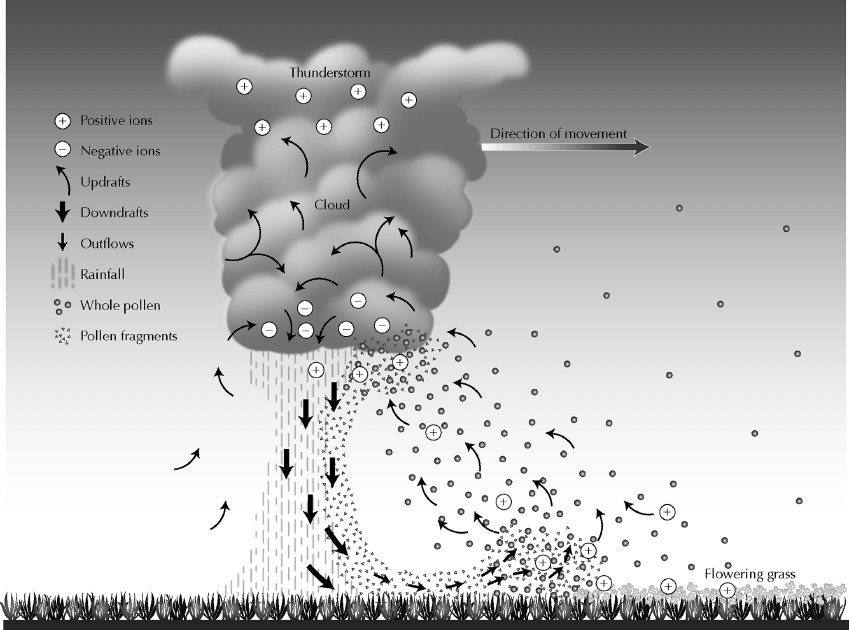
Figure 1. A schematic description of the mechanism that enhances the concentrations of airborne aerosols (either pollution particles or pollen) ahead of a mature thunderstorm (Taylor and Jonsson,